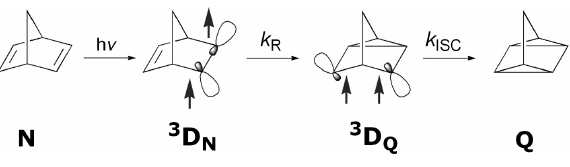
Figure 1. The mechanism of valence isomerisation from norbor- nadiene to quadricyclane. The different species are norborna- diene (N), norbornadiene diradical ( 3 D N ), quadricyclane diradical ( 3 D Q ), quadricyclane